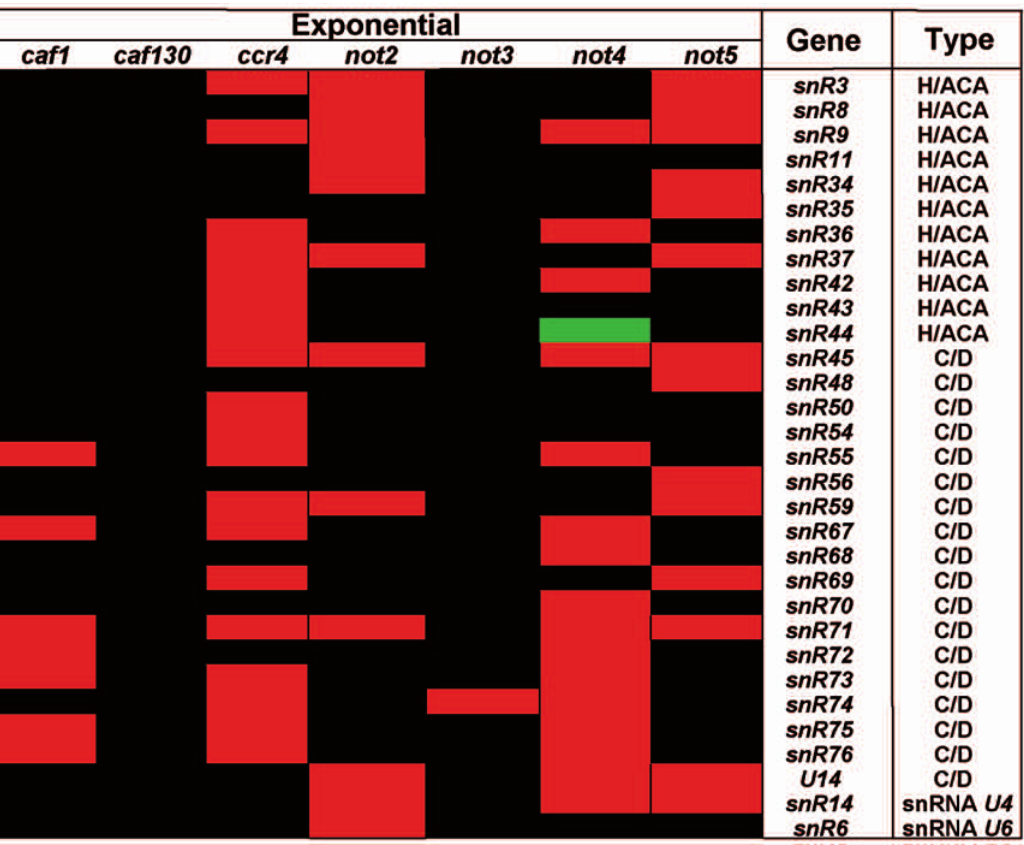
Figure 1. Polyadenylated non-coding snRNAs and snoRNAs are over-expressed in specific mutants of the Ccr4-Not complex. This figure lists all of non-coding snoRNAs and snRNAs identified in our previous micro-array experiments [38] as being differentially expressed in any mutant of the Ccr4-Not complex growing exponentially compared to the wild-type. Black, red and green shows genes that are not affected, over- expressed or under-expressed, respectively. In the last column is indicated which category the gene belongs to either a H/ACA or C/D snoRNA, or a snRNA.